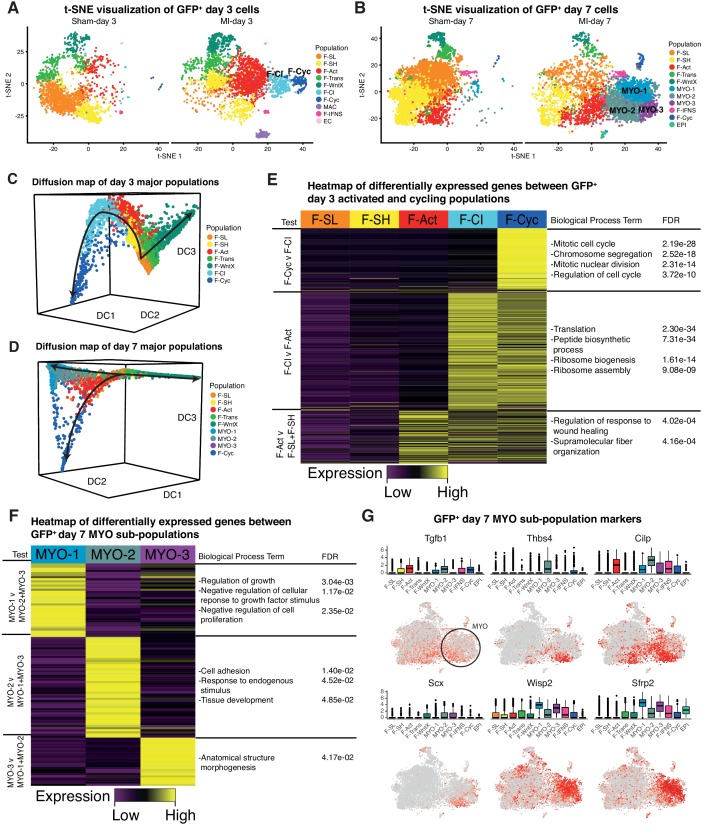
Time-point-specific analysis of GFP+ scRNA-seq.(A,B) t-SNE visualization of GFP+ populations 3 days post sham/MI (A) and 7 days post sham/MI (B). (C,D) 3D Diffusion Map analysis of day 3 major populations (C) and day 7 major populations (D). (E) Heatmap of upregulated genes in day 3 injury-response populations. (F) Heatmap of differentially expressed genes between myofibroblast sub-populations. (G) Gene expression visualized in box and t-SNE plots for myofibroblast sub-population marker genes.